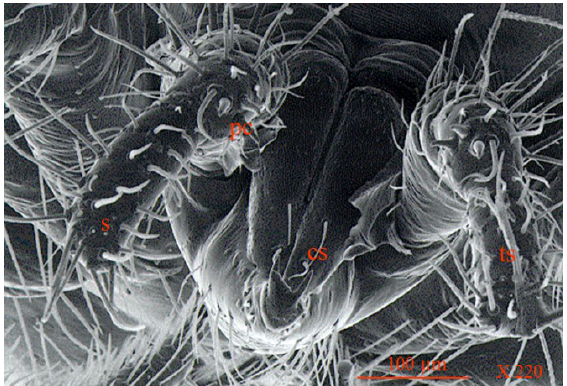
Figure 8. Scanning electron micrograph of gnathosoma region of Anystis baccarum . Palptibia bears three claws (pc); palptarsus bears four small solenidia (s) and many long serrated setae of which the terminal setae is the longest (ts); the chelicerae each bear two setae (cs) (Photo: Andrew G. S. Cuthbertson © ).